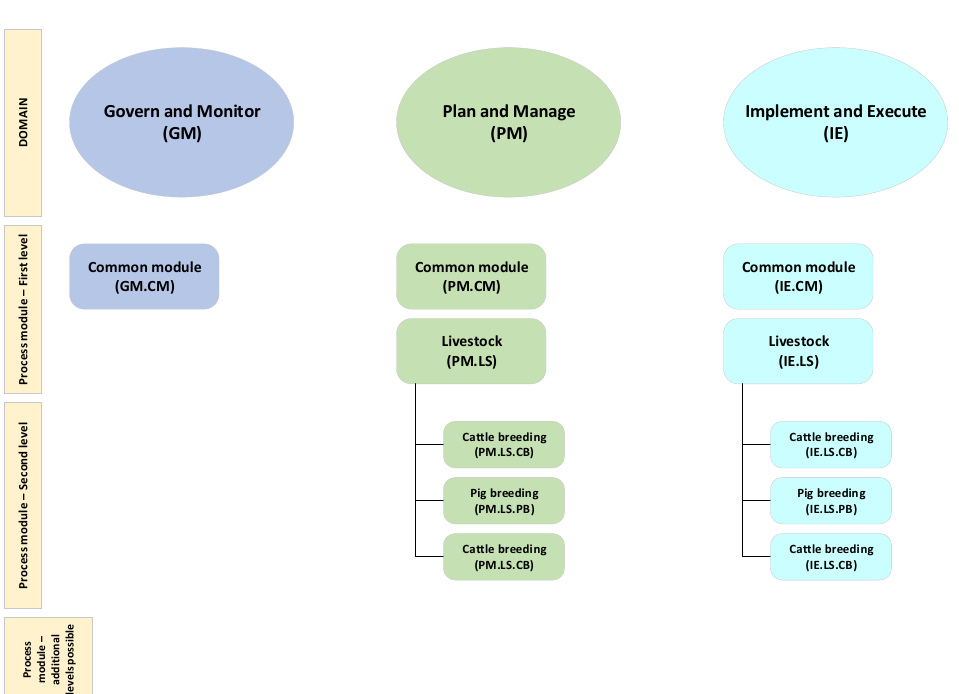
Figure 3. RSPMA domains and hierarchy of process modules.